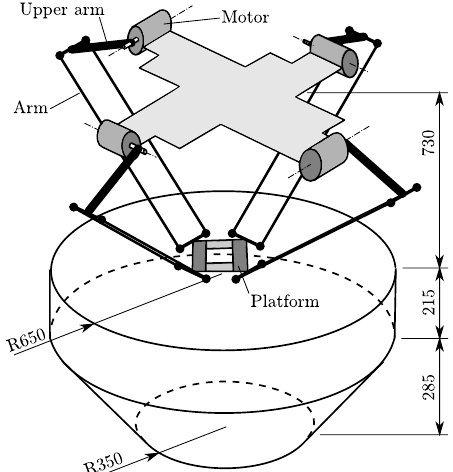
Figure 1. The 4-DOF parallel robot and its workspace limits in mm